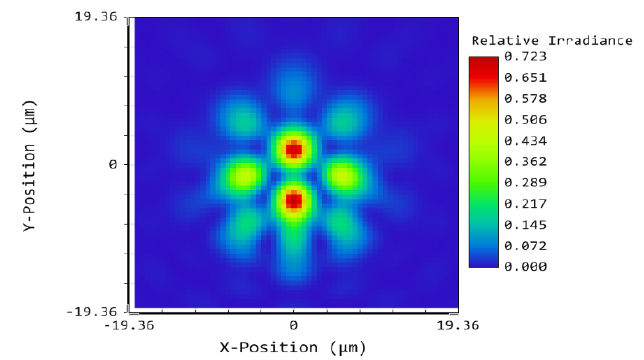
Figure 11. The PSF of the Golay3 MMT.